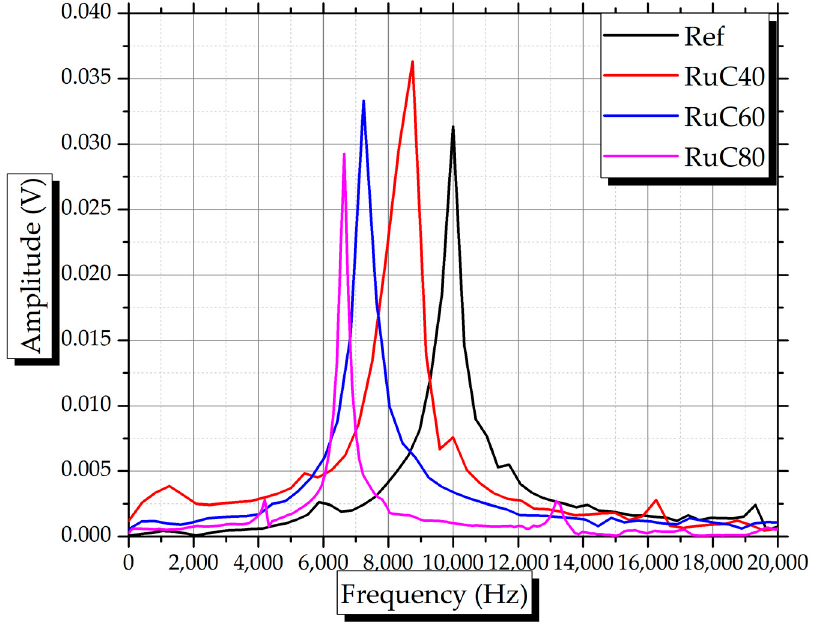
Figure 9. Shift of the fundamental frequency of vibration as a function of rubber content.